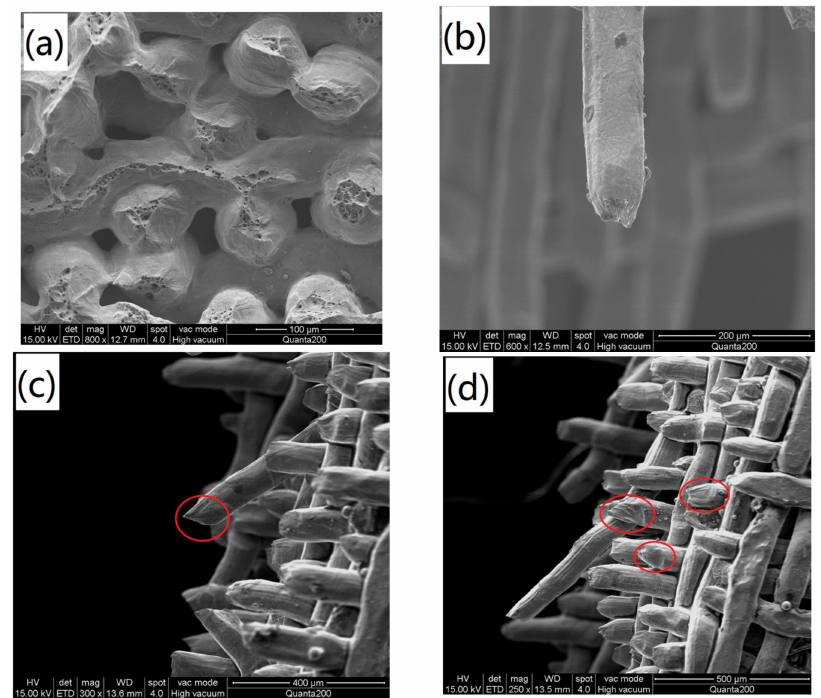
Figure 6. Fracture morphology (SEM) after the tensile test: ( a ) the end face with dimple; ( b ) the wire necking; ( c ) the wedge-shape fracture; and, ( d ) the tearing-mode fracture.